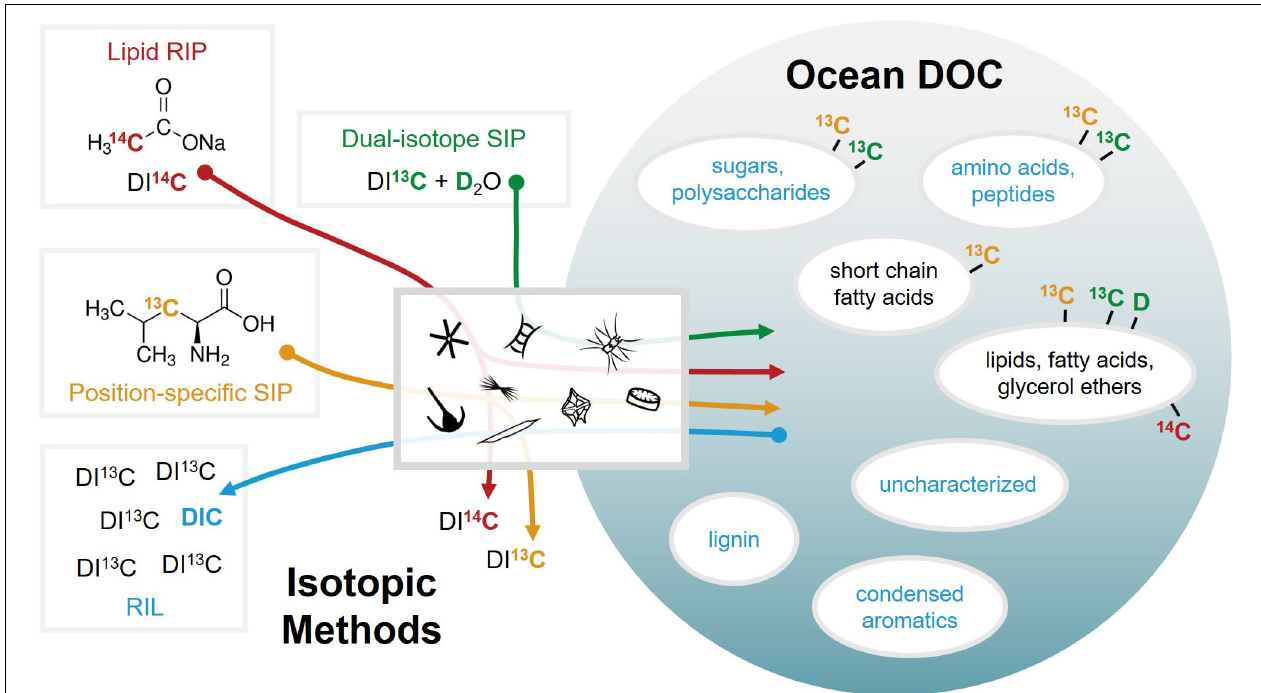
FIGURE 3 | Emerging stable ( 13 C) and radiocarbon ( 14 C) isotopic techniques used to probe metabolic pathways for the biosynthesis and microbial turnover of DOC by planktonic communities in the ocean. These methods include position-specific and dual-isotope stable isotope probing (SIP), lipid radioisotope probing (RIP), and reversed isotope labeling (RIL). The sphere is shaded according to the apparent recalcitrance of DOC compound